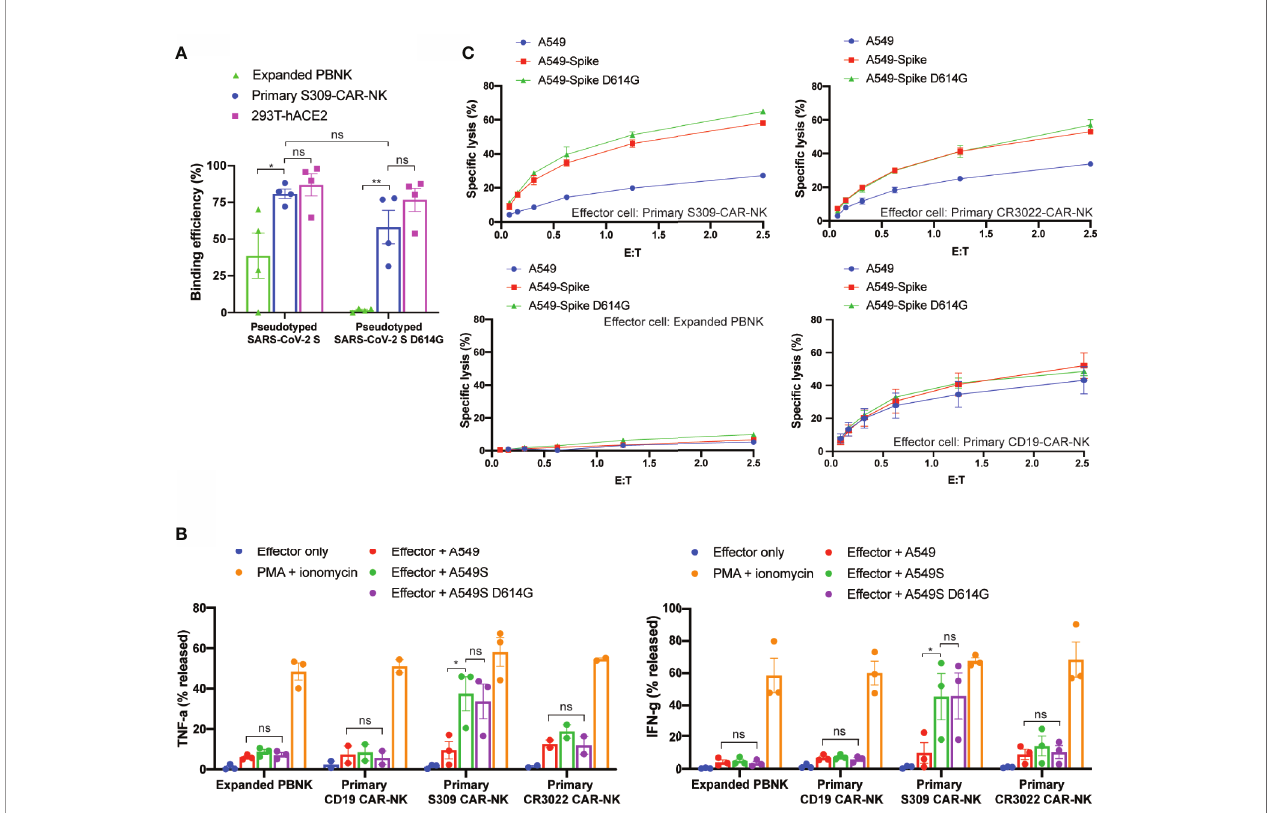
FIGURE 6 | S309-CAR-NK primary cells can also target SARS-CoV-2 D614G variant. (A) Quantitative data of the binding ef fi ciency of S309-CAR-NK primary to pseudotyped SARS-CoV-2 and D614G variant viral particles. (B) Intracellular cytokine productions of various effector cells. Brie fl y, effector cells were cocultured with A549, A549-Spike, or A549-Spike D614G for 4 hours at 37°C. Cells were then stained for surface markers and permeabilized prior to staining for intracellular cytokines. Data were acquired by fl ow cytometry and the values were normalized with the PMA + ionomycin group (positive control). Data were pooled from at least two independent experiments. (C) Expanded S309-CAR-NK primary has increased killing activity against A549-Spike and A549-Spike D614G cells compared to CR3022-CAR-NK primary . Effector cells were blocked with anti-CD16 and anti-NKG2D prior to coculturing with A549-Spike or A549-Spike D614G target cells for 4 hours at 37°C. Primary NK cells and CAR-NK primary cells were expanded from at least four donors. Representative data from one donor is shown. Samples were performed in triplicates. Error bars represent means ± SD. Non-parametric test was employed for panels (A, B) . ns p > 0.05 and *p <